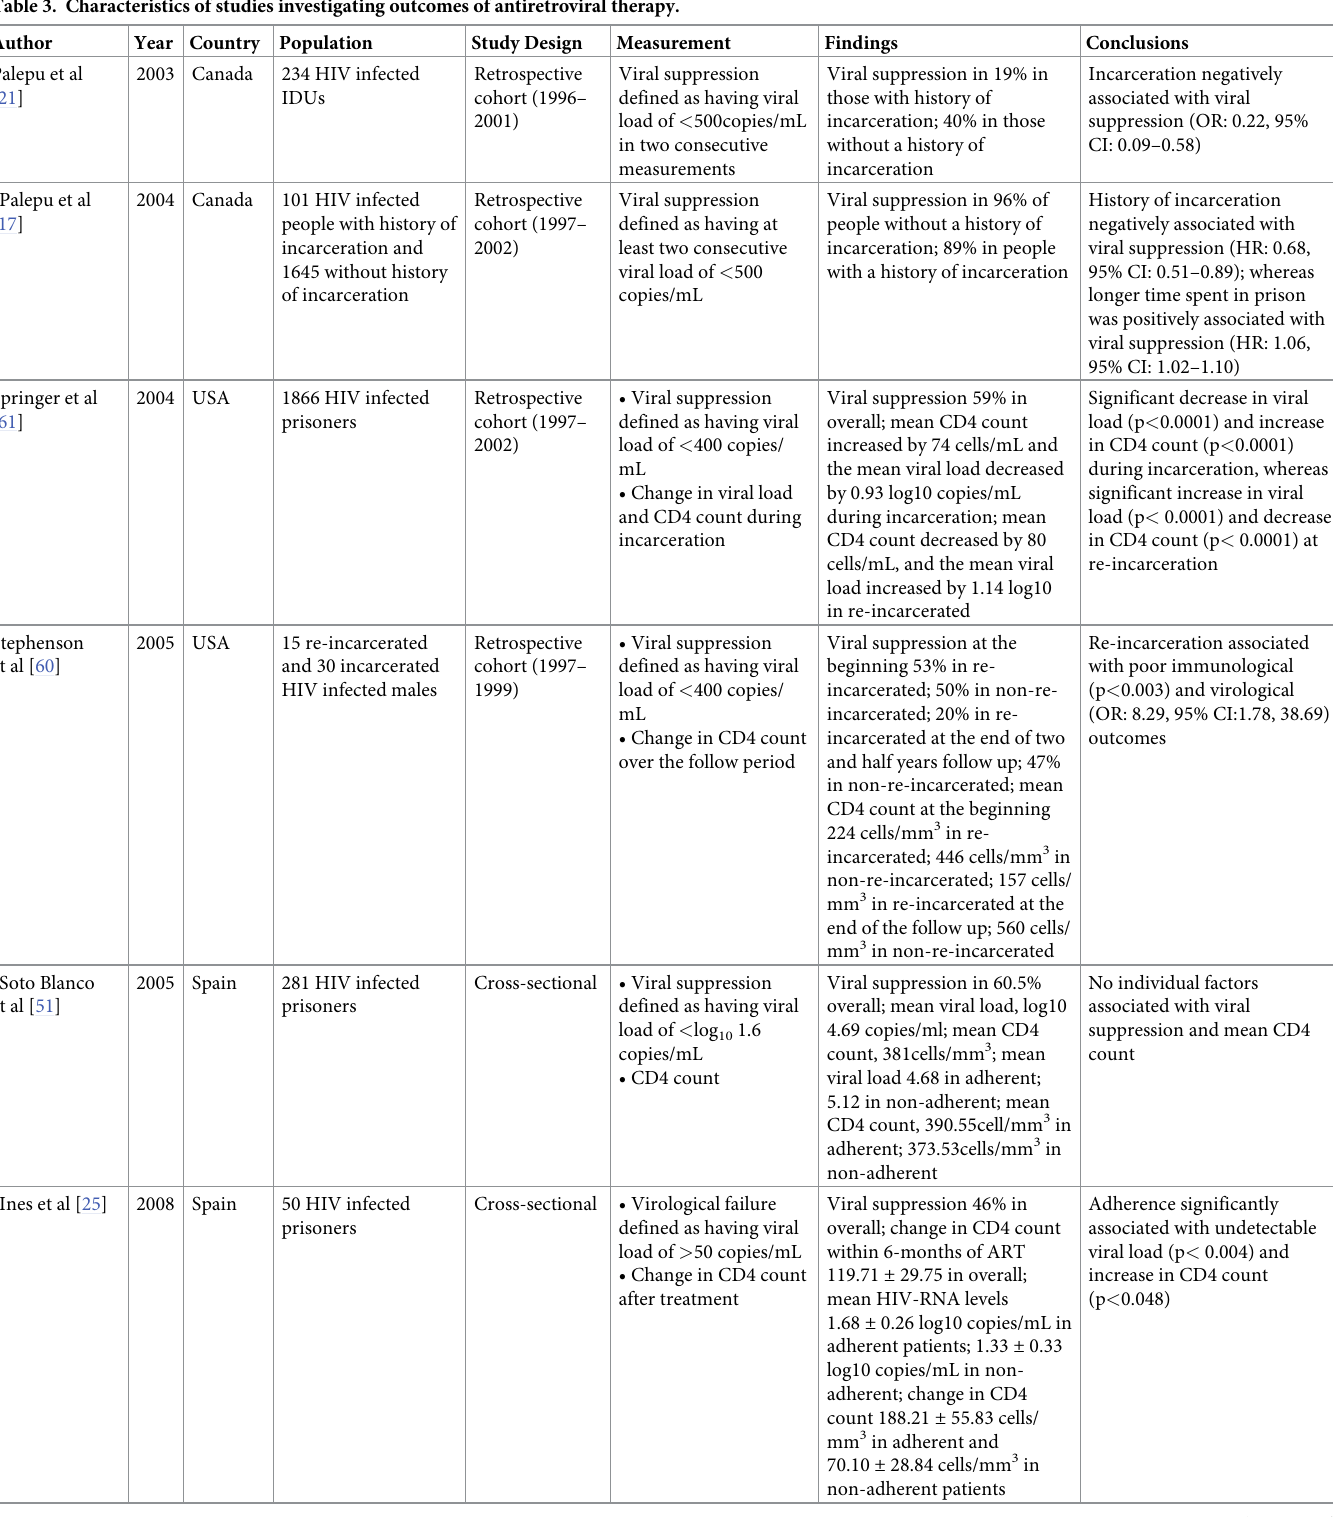
Table 3. Characteristics of studies investigating outcomes of antiretroviral